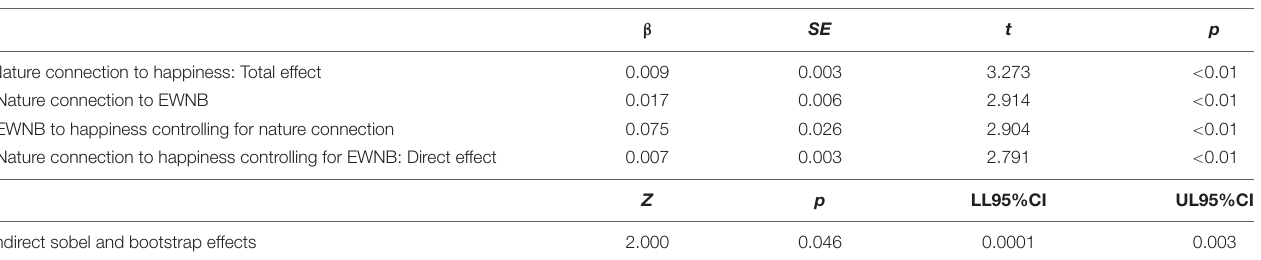
TABLE 5 | Mediation analysis for changes in happiness, nature connection, and EWNB (5000 Bootstrap Samples).